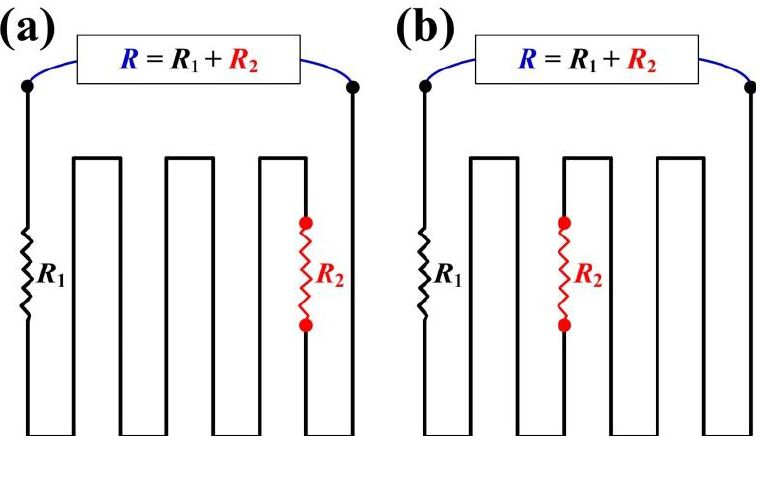
Figure 1. Explanations of the ambiguous judgments from a conventional resistive strain sensor, on which combinational resistance cannot identify local behaviors. The superimposed total resistance ( R ) in ( a ) and ( b ) cannot reflect different local resistances ( R and R ) and their 1 2